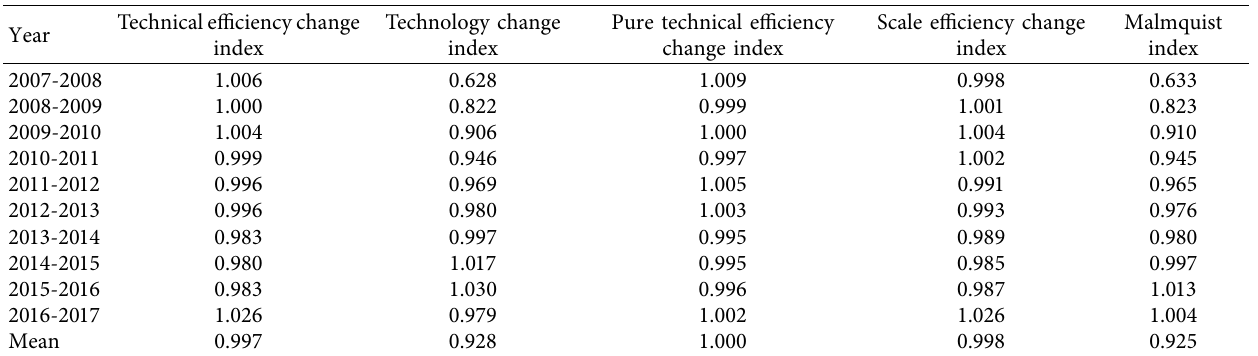
Table 6: Malmquist index and decomposition efficiency of Beijing-Tianjin-Hebei Metropolitan